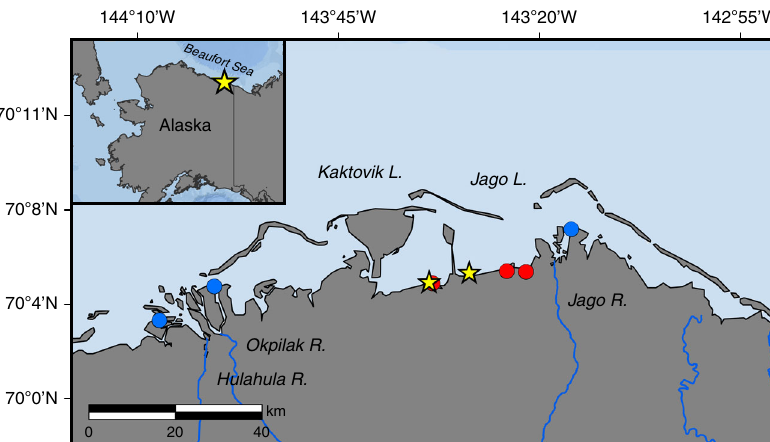
Fig. 1 Map showing general locations of study sites along the eastern Alaska Beaufort Sea coast. Samples were collected from soils (red circles), groundwater (yellow stars), and river water (blue